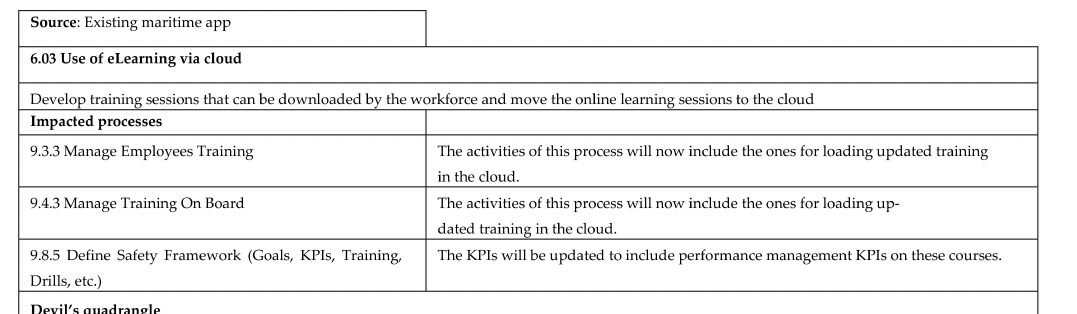
Figure A40. Use of SaaS via cloud data sheet.